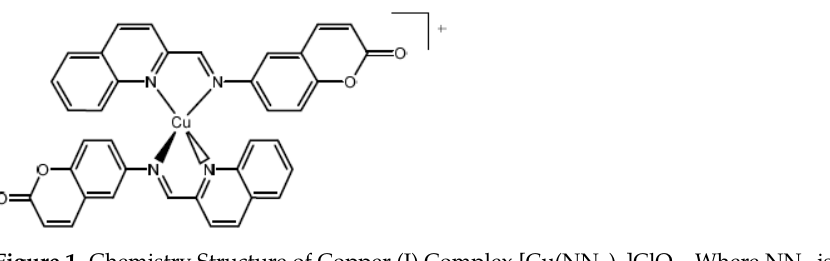
Figure 1. Chemistry Structure of Copper (I) Complex [Cu(NN 1 ) 2 ]ClO 4 . Where NN 1 is 6-((quinolin-